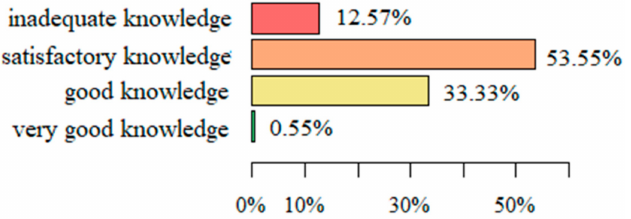
Figure 2. The level of knowledge regarding issues of HF patients and their preparation for